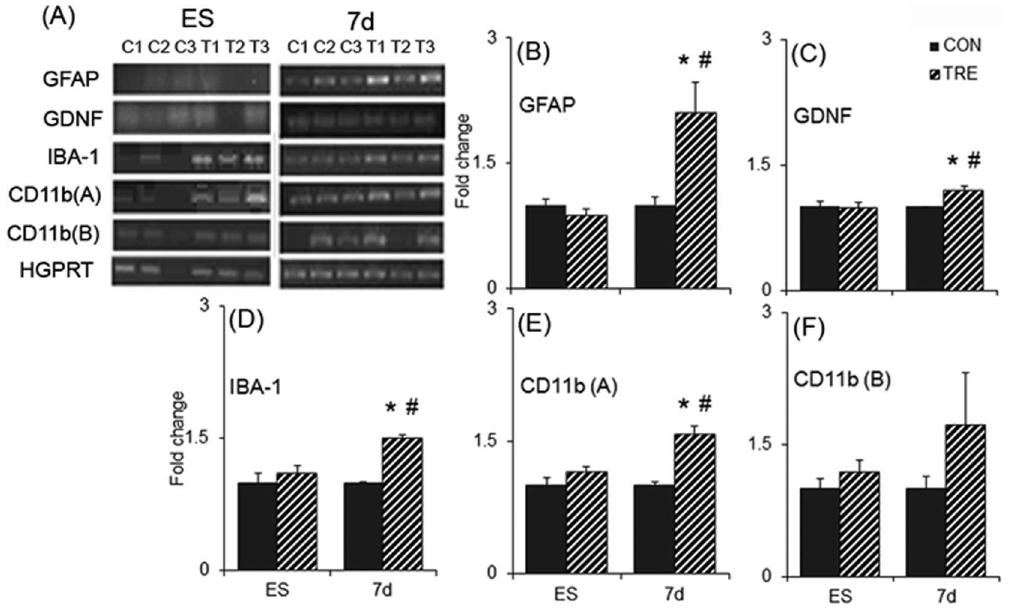
Figure 11. mRNA expression of certain glial markers in the striatum. (A) Gels showing amplified cDNA bands for different primers. The cDNA was prepared from the mRNA isolated from the control and treated sides of the striatum of the embryonic stem cells, undifferentiated (ES) and 7 days differentiated (7 d) cell transplanted groups. Ratios of the band intensities for GFAP (B), GDNF (C), IBA-1 (D), CD11b-A (E) and CD11b-B (F) as normalised with hypoxanthine-guanine phosphoribosyl transferase (HGPRT) and fold change of band intensities of the treated side compared to the control side was calculated for each animal. Results are presented as Mean 6 SEM. * p # 0.05 vs control side of the same group, # p # 0.05 vs treated side of the ES transplanted group, n=3.